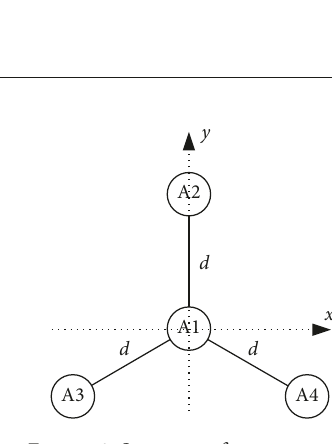
Figure 2: Structure of antenna